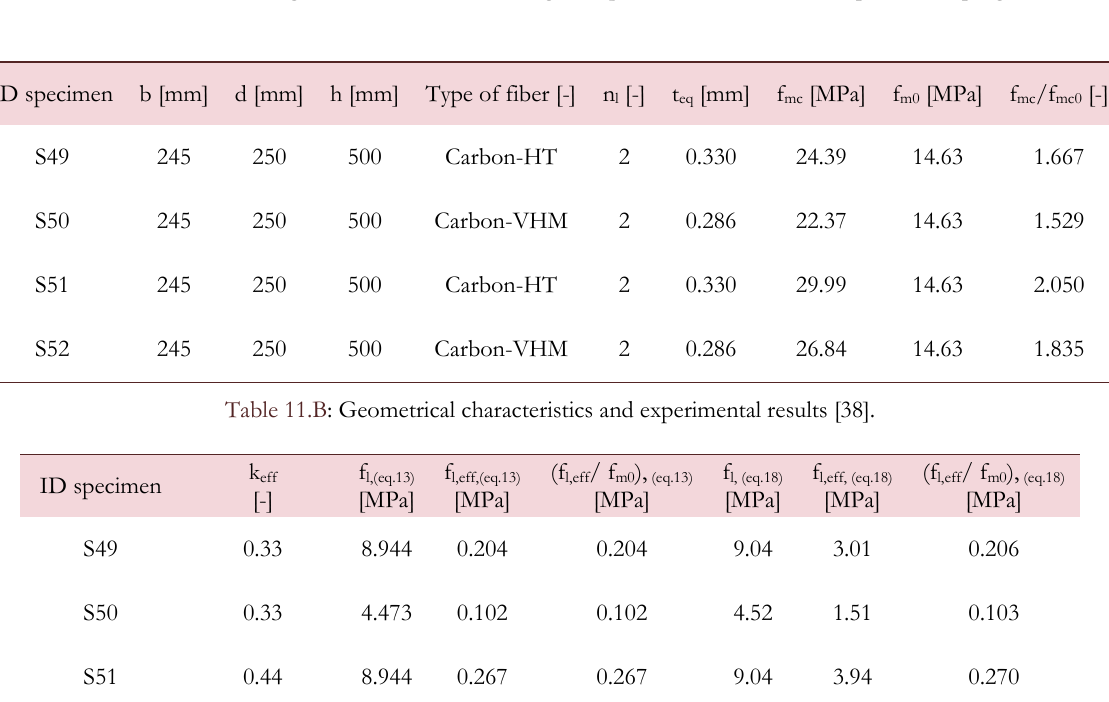
Table 10.B: Effective confining stress calculated according to Eqn. (13) and (18) for the experimental program, [37].